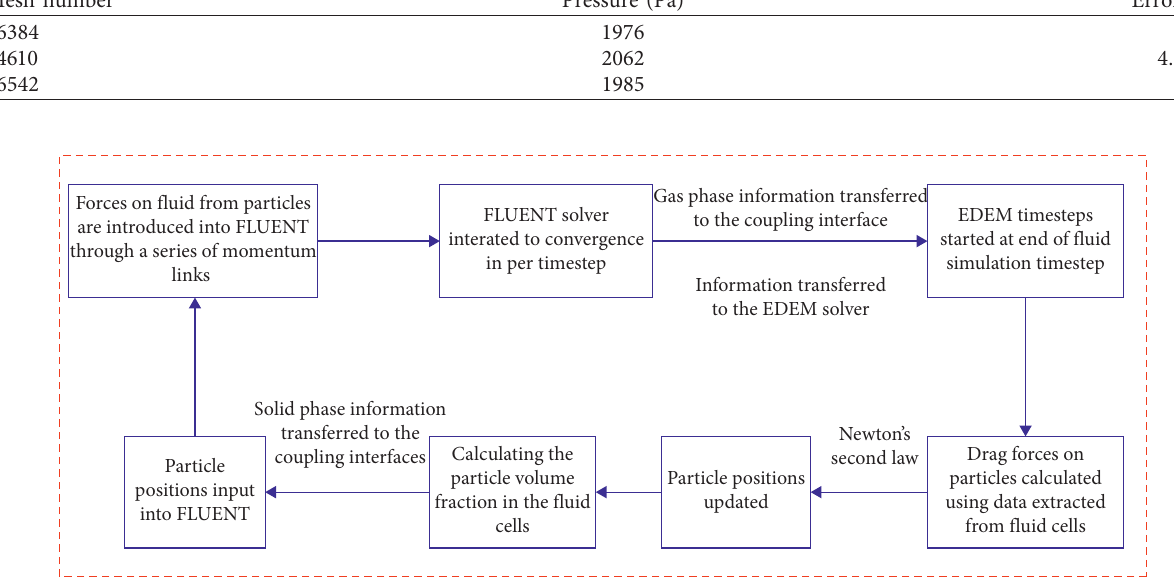
Figure 2: The process of FLUENT-EDEM coupling